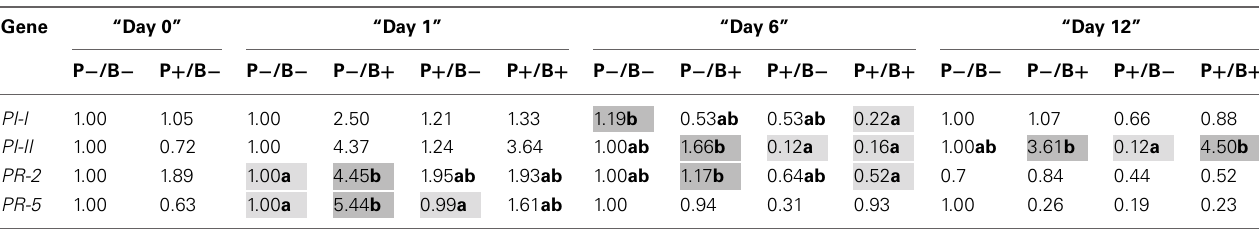
Table 1 | Transcriptional profiles of four gene markers: PI-I and PI-II (JA/ET-responsive genes) and PR-2 and PR-5 (SA-responsive genes) in P. fluorescens pre-inoculation (P + ) and non-inoculated (P − ) tomato plants, with or without (control) B. tabaci infestation (B + and B − , respectively).